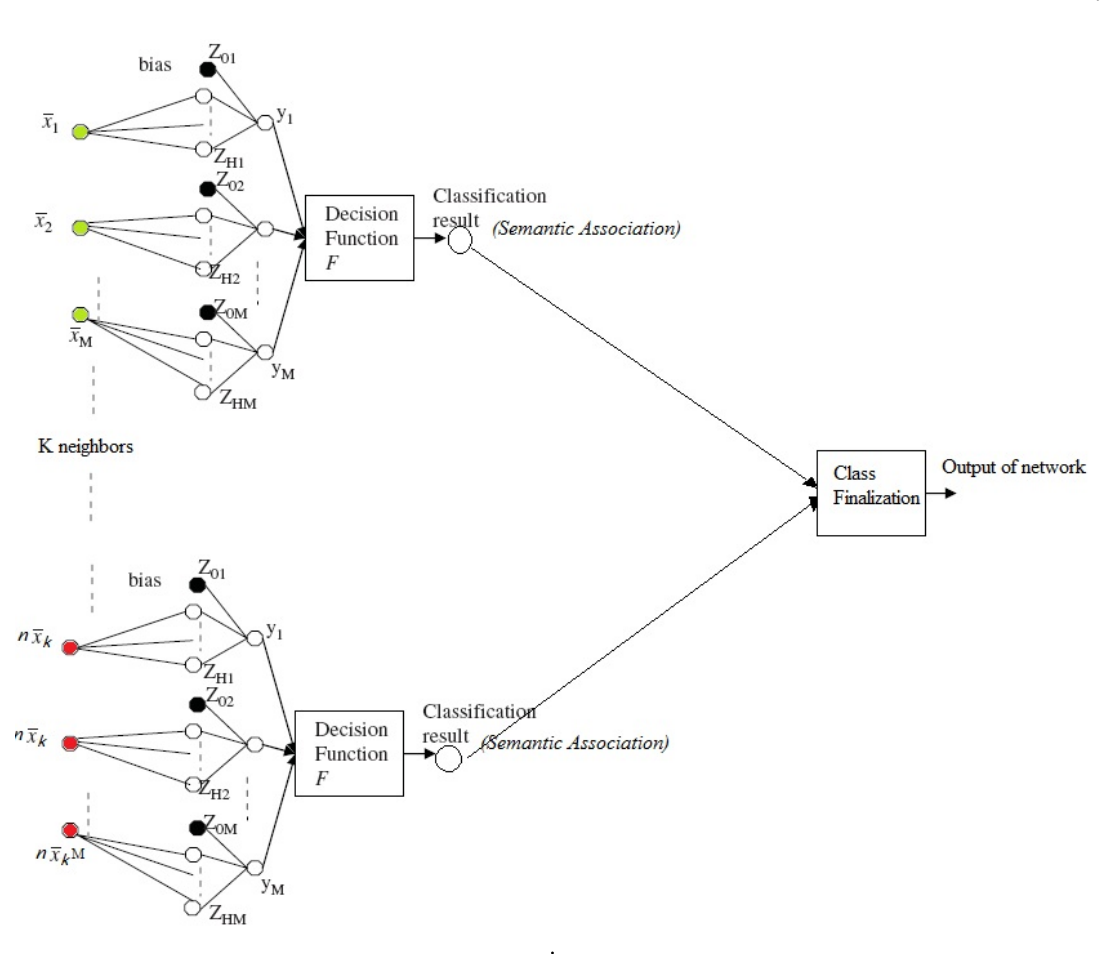
Fig. 6. Process of semantic association and class finalization.